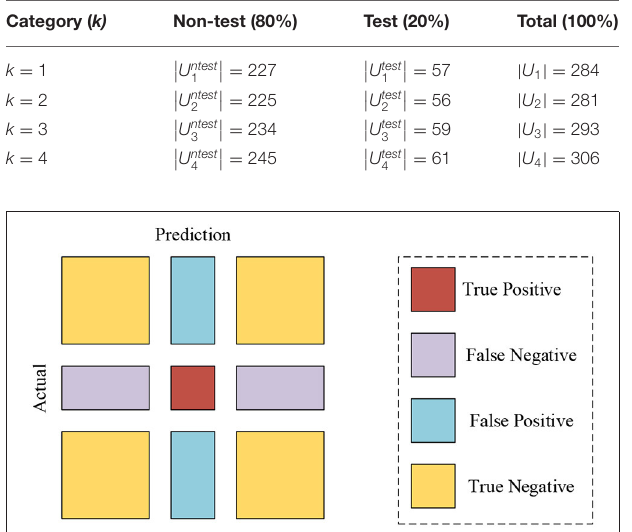
TABLE 5 | Splitting setting of our dataset.